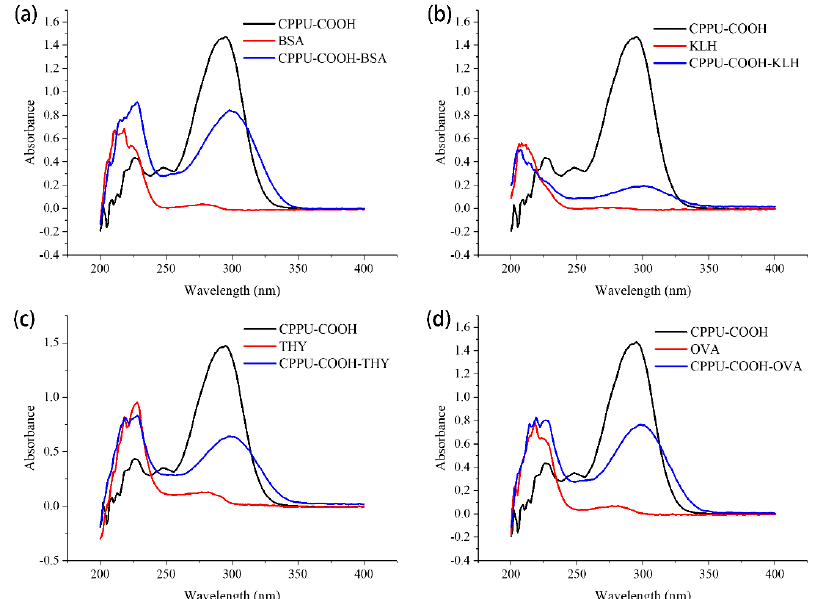
Figure 2. UV spectra of hapten, carrier proteins, and artificial antigens. ( a ) CPPU-COOH-BSA; ( b ) CPPU-COOH-KLH; ( c ) CPPU-COOH-THY; ( d ) CPPU-COOH-OVA. CPPU-COOH-BSA, CPPU- COOH-KLH, CPPU-COOH-THY, and CPPU-COOH-OVA exhibited a distinct pattern of absorbance, reflecting properties of the carboxyl on the hapten to amino groups of the carrier protein. Table 1. Characterization of mice antisera against CPPU with different coating